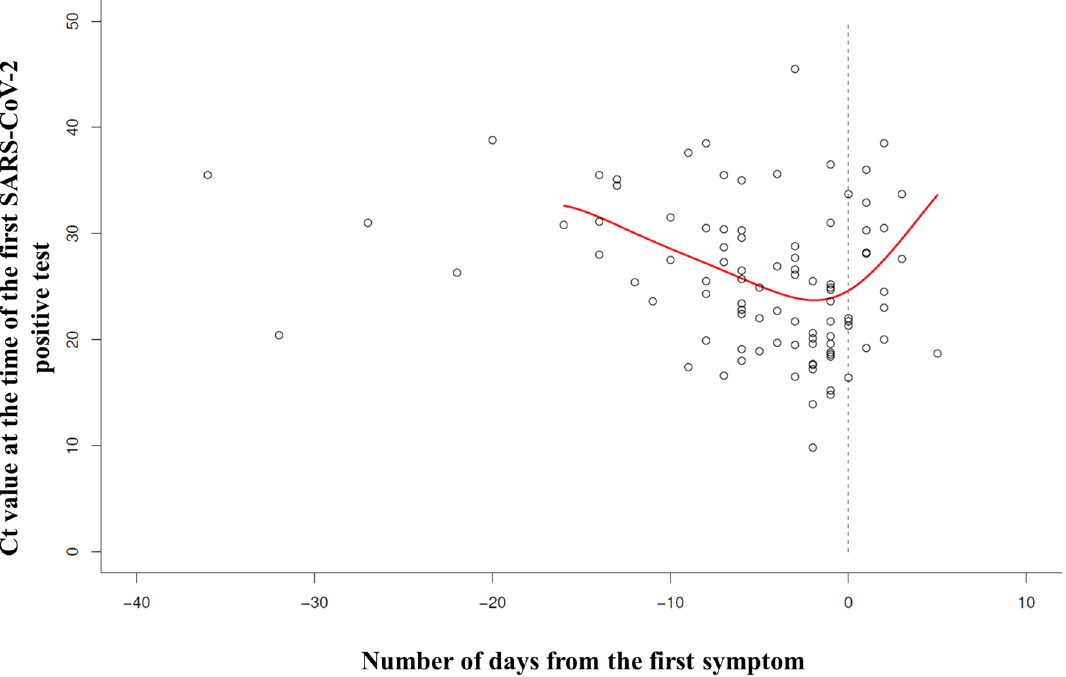
Figure 6. The correlation between Ct value of the first positive test and the time of initial symptom onset. Figure shows the correlation between diagnostic Ct value (performed on day 0) and the day of initial symptoms’ onset. Each small circle represents one unique symptomatic patient (the six completely asymptomatic patients were excluded from the analysis; additionally, another four patients with unknown absolute positive Ct value were excluded). To the right of the dashed line, a total of fourteen patients detected as contacts are shown (e.g. symptoms appeared after sampling). Patients already symptomatic at the time of the first positive PCR test sampling (N = 81) are displayed directly on the dashed line and to the left side of the dashed line. The correlation red curve between diagnostic Ct values and sampling time in relation to the symptoms’ onset is plotted